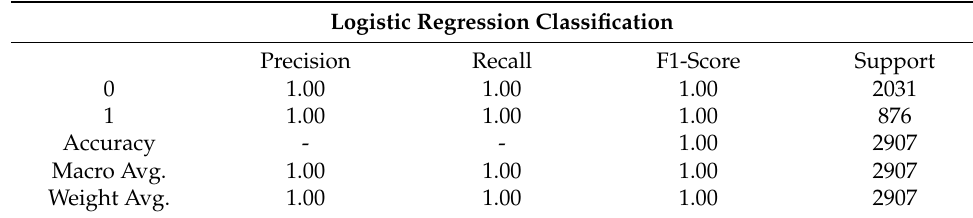
Table 2. Logistic regression classification report.